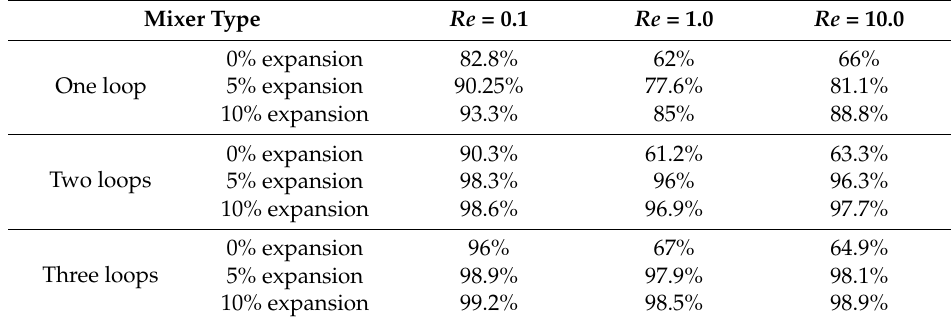
Table 4. The efficiency of the mixers calculated according to Equation (8). The Reynolds numbers are based on the accumulative discharge of the inlets at the smallest cross-section of the